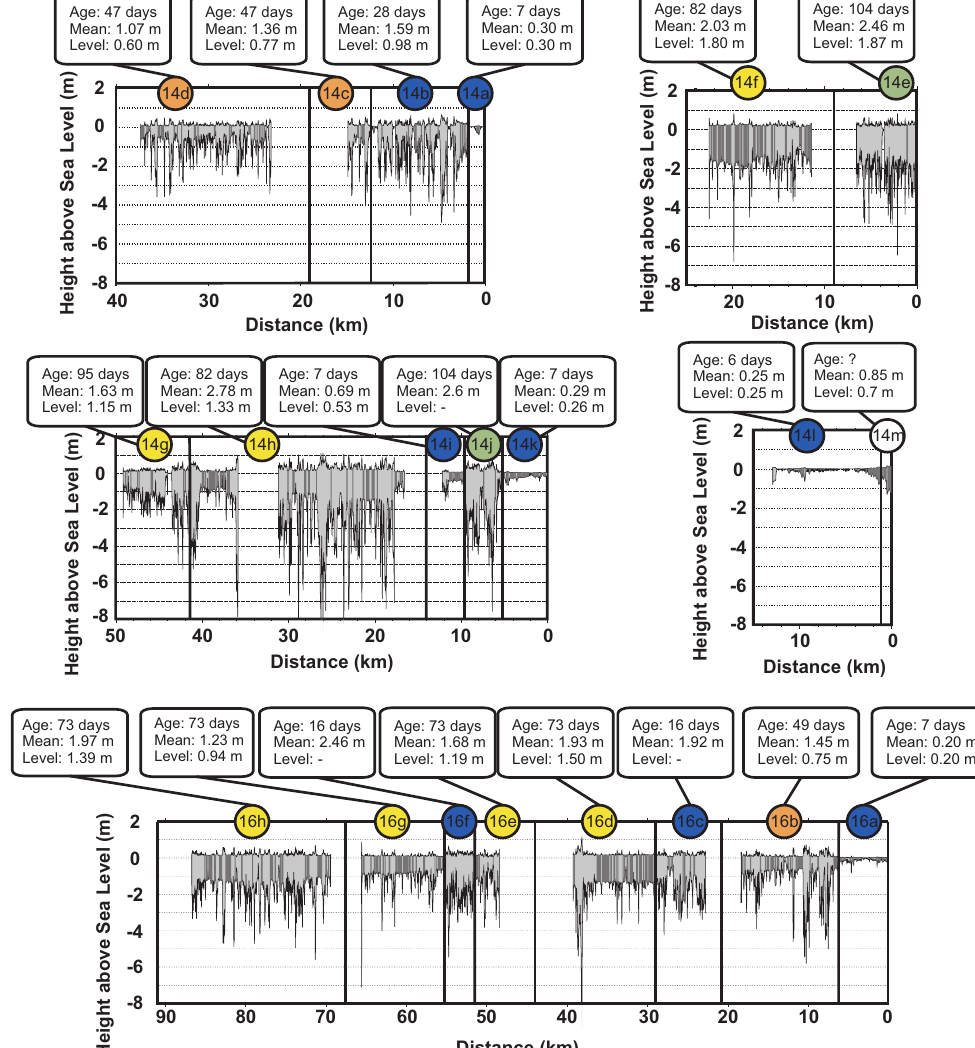
Fig. 6. Results of all HEM profiles shown in Fig. 5. For visualization, results are shown as draft–freeboard profiles, where a freeboard–draft ratio of 0.89 was assumed. Text boxes next to each draft–freeboard plot show age, mean thickness, and level ice thickness of the corresponding subsection. Zones of level ice in the profiles are highlighted dark. Circle colors refer to the polynya events in which the respective sea-ice profiles originated (for color code, see Table 1).